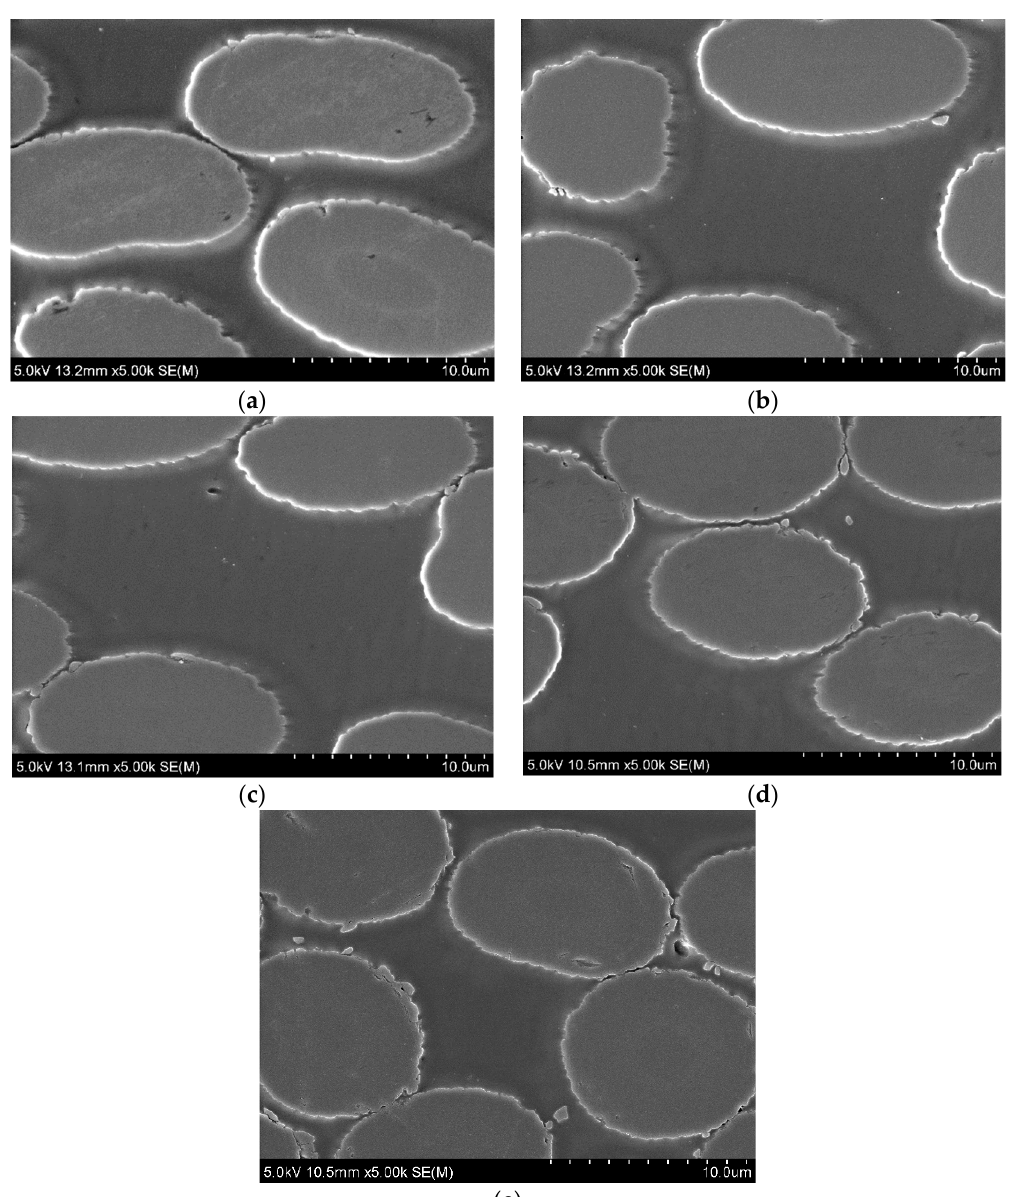
Figure 3. Microstructure observation of CFRP: ( a ) reference; ( b ) Elium ® /0.0075 SWCNT; ( c ) Elium ® /0.01 SWCNT; ( d ) Elium ® /0.015 SWCNT; ( e ) Elium ® /0.02 SWCNT.